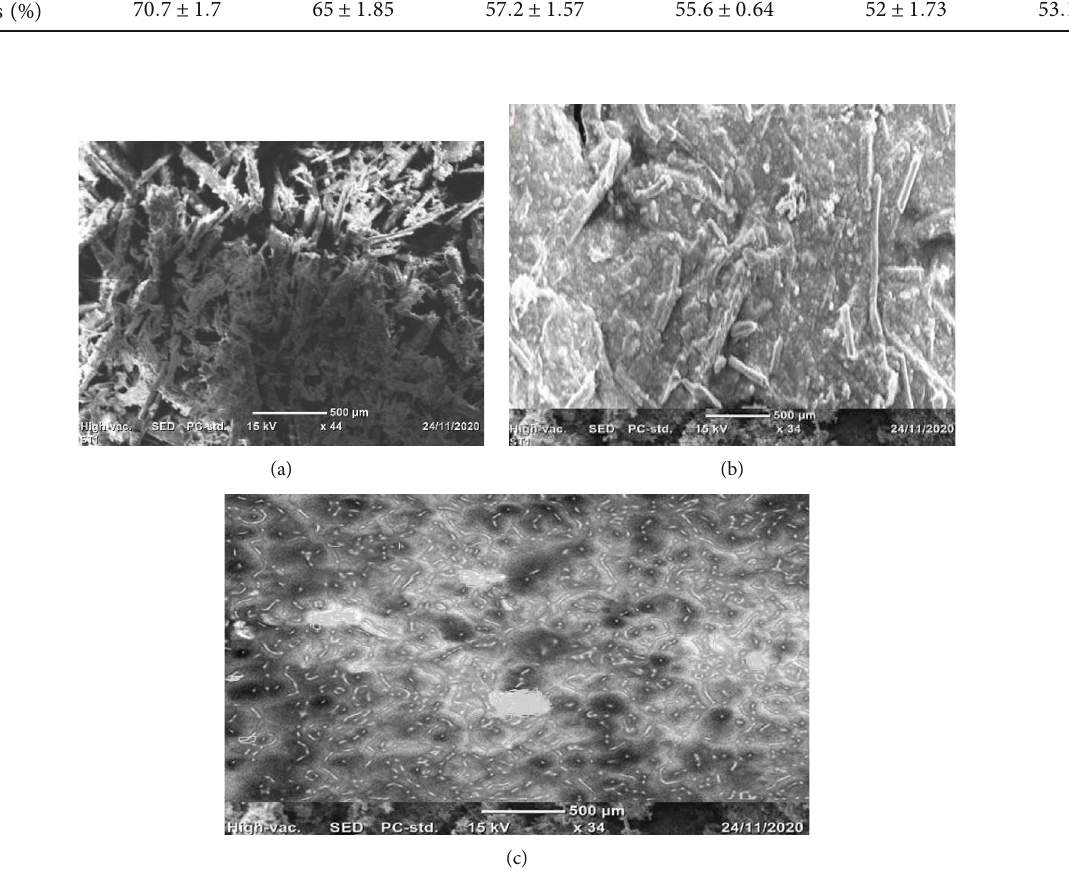
Figure 7: Scanning electron microscopy image for (a) te ff straw, (b) nanocellulose, and (c) PVA-6%NC composite fi